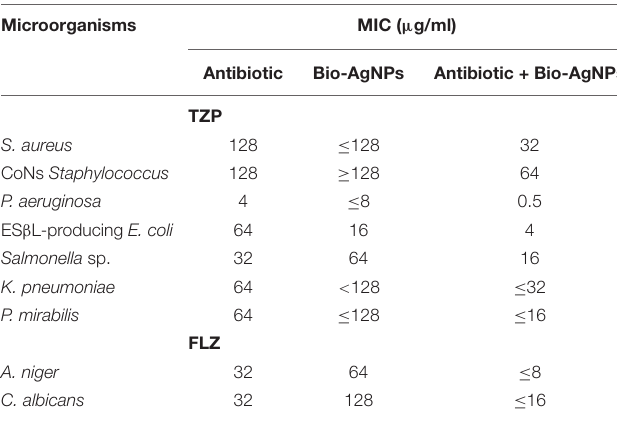
TABLE 3 | Minimum inhibitory concentration (MIC) of antibiotic alone, Bio-AgNPs alone, or their combination against various pathogenic microorganisms